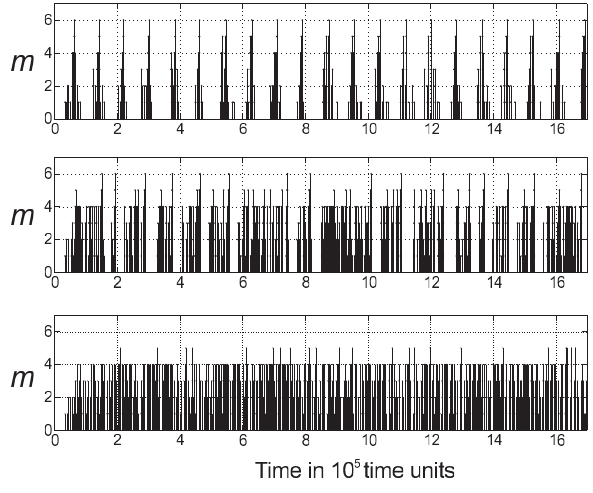
Fig. 10. Three seismic regimes: sample of earthquake sequences. Top panel – regime H (High), ∆ H = 0 . 5 · 10 4 ; middle panel – regime I (Intermittent), ∆ H = 10 3 ; bottom panel – regime L (Low), ∆ H = 0 . 5 · 10 3 . Only a small fraction of each sequence is shown, to illustrate the differences between regimes. Reproduced from Zaliapin et al. (2003a), with kind permission of Springer Science and Business Media.